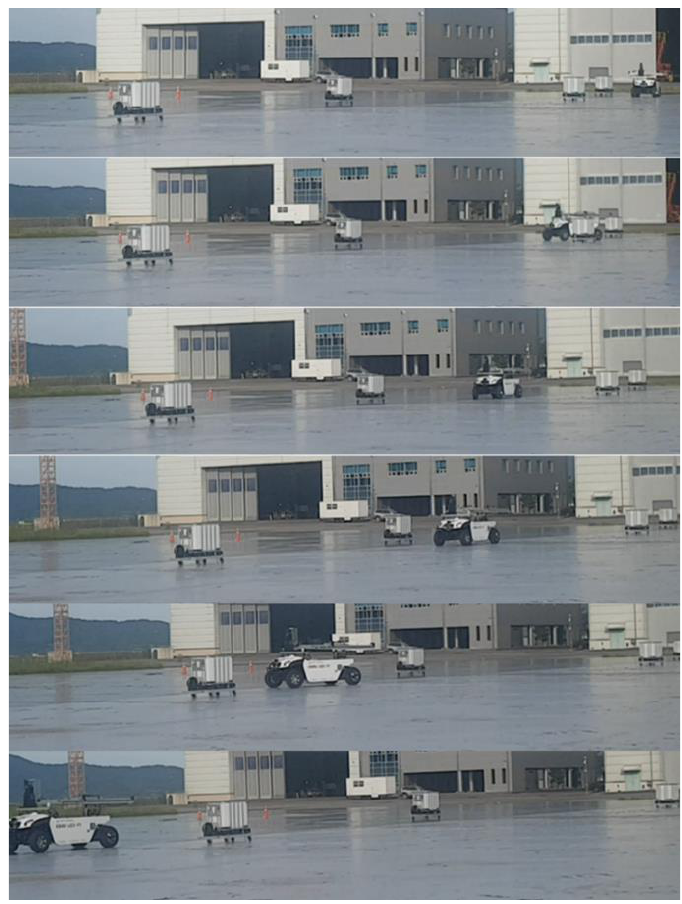
Figure 10. Concept diagram for avoiding multiple obstacles.